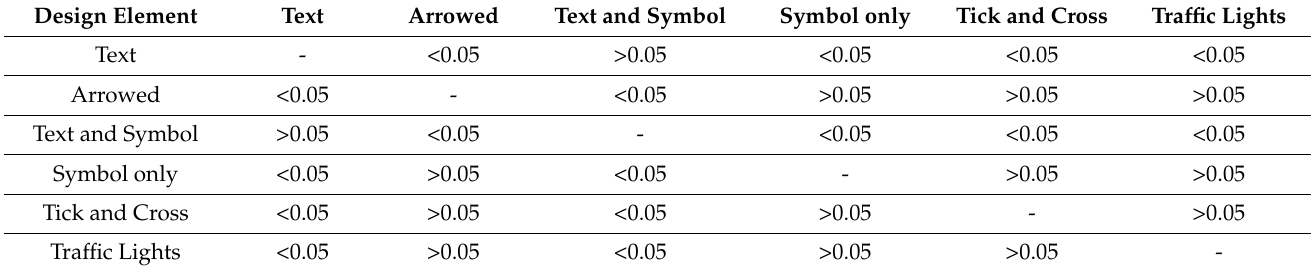
Table 3. The p values of six types of pairwise comparative analyses. If p < 0.05, the evaluation scores between factors were significant.